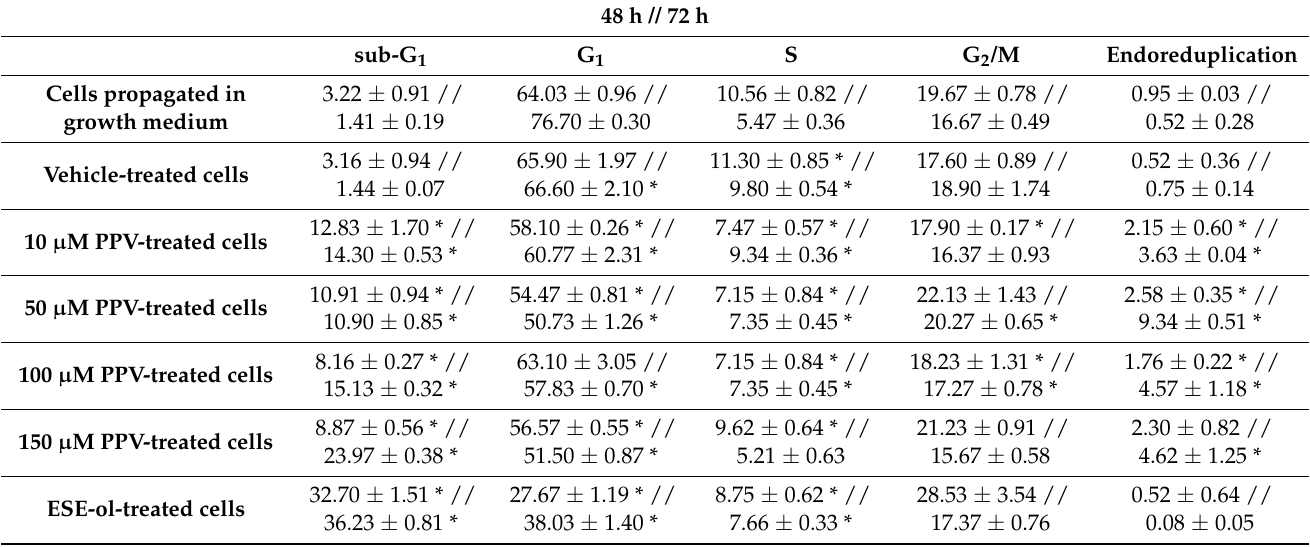
Table 3. The effects of PPV on cell cycle and cell death induction as a percentage of cells in each phase of the cell cycle on DU145 cells at 48 h // 72 h. Statistical significance is represented by an * when using the Student t-test with a p value of 0.05 compared to cells propagated in growth